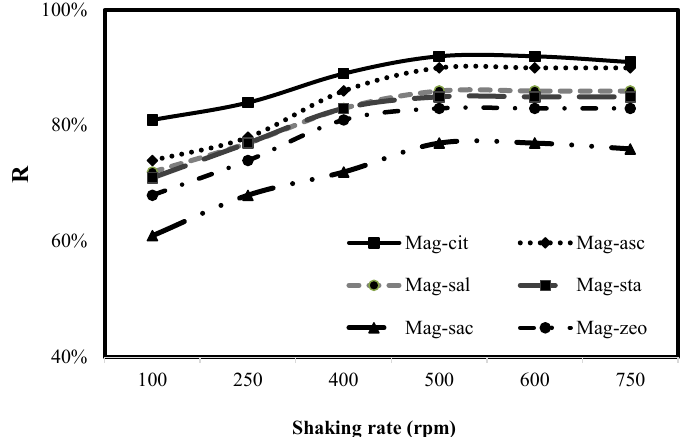
Fig. 12. Effect of shaking rate on the removal of Co(II) (pH: 8, Co(II) concentration: 25